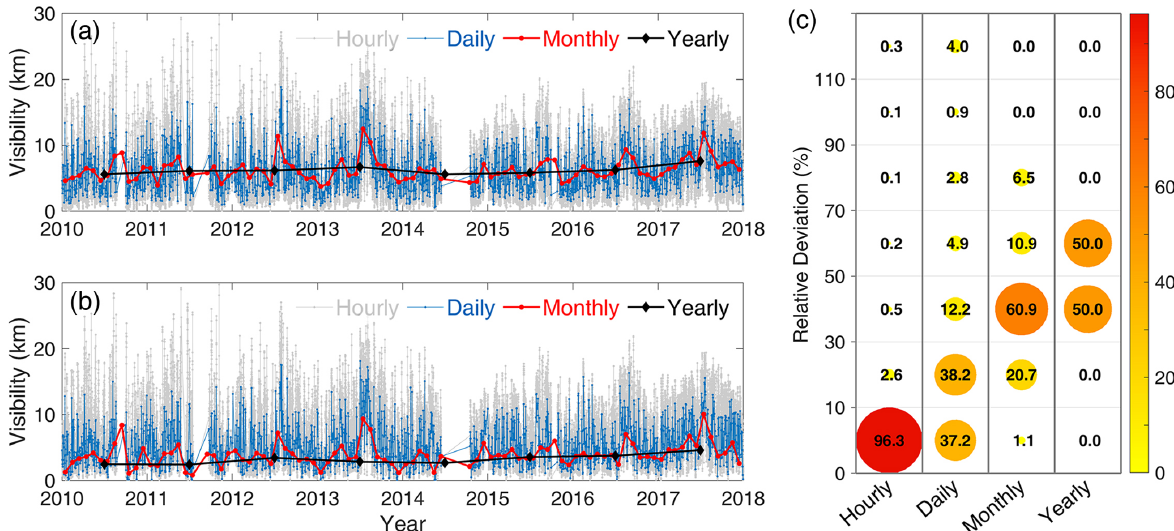
Figure 1. Comparison of arithmetic average visibility and harmonic average visibility: (a) arithmetic average visibility calculated using Eq. (2). (b) Harmonic average visibility calculated using Eq. (3). (c) Distribution of the relative deviation of arithmetic average visibility from harmonic average